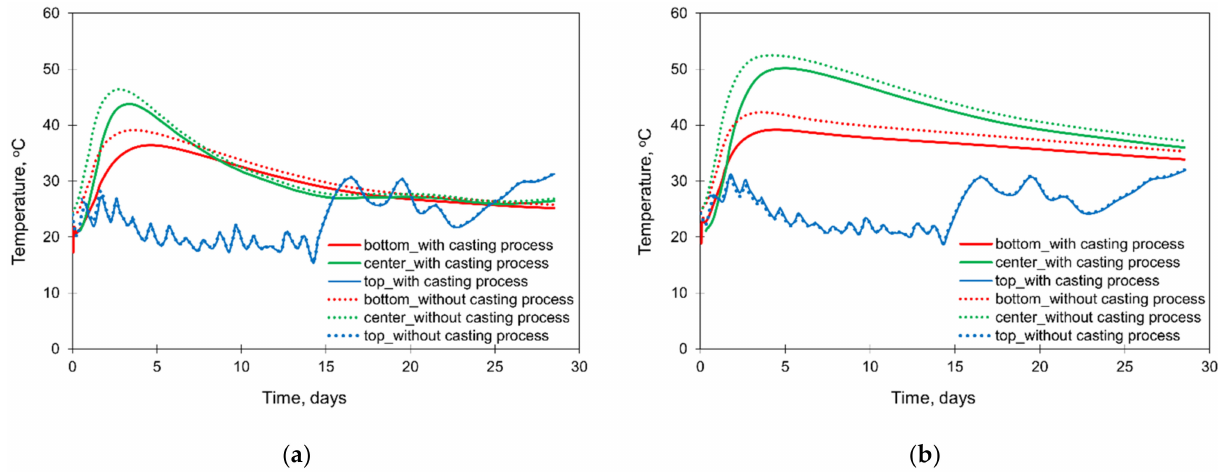
Figure 13. The influence of the casting modelling on the development of hardening temperature in the slabs with the thicknesses of ( a ) 2 m and ( b ) 4